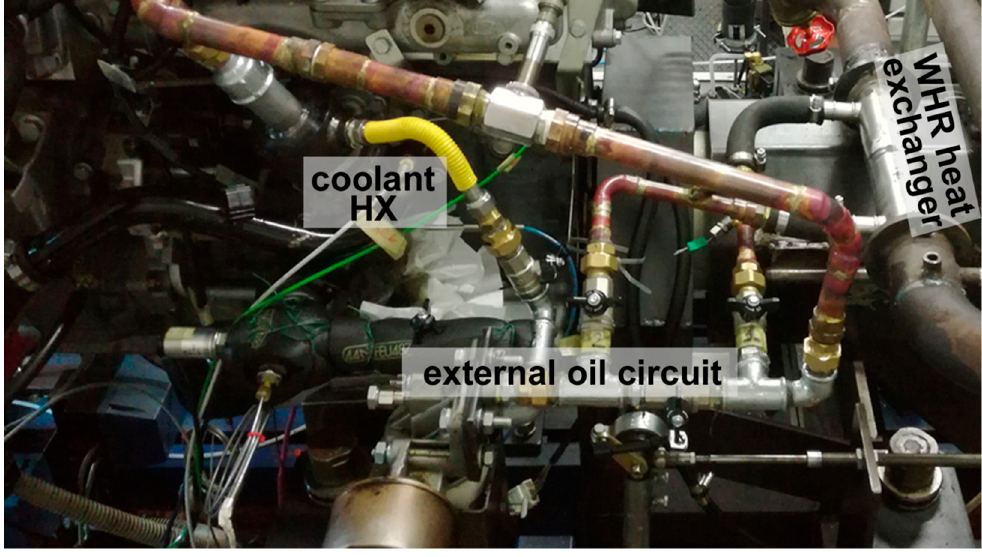
Figure 6. Experimental arrangement of the heat exchanger in the external oil circuit on the engine test